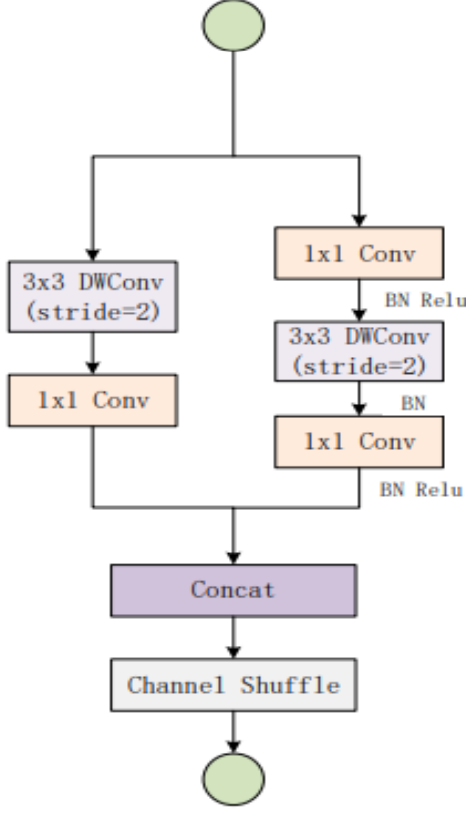
Figure 5. huffle Net basic unit